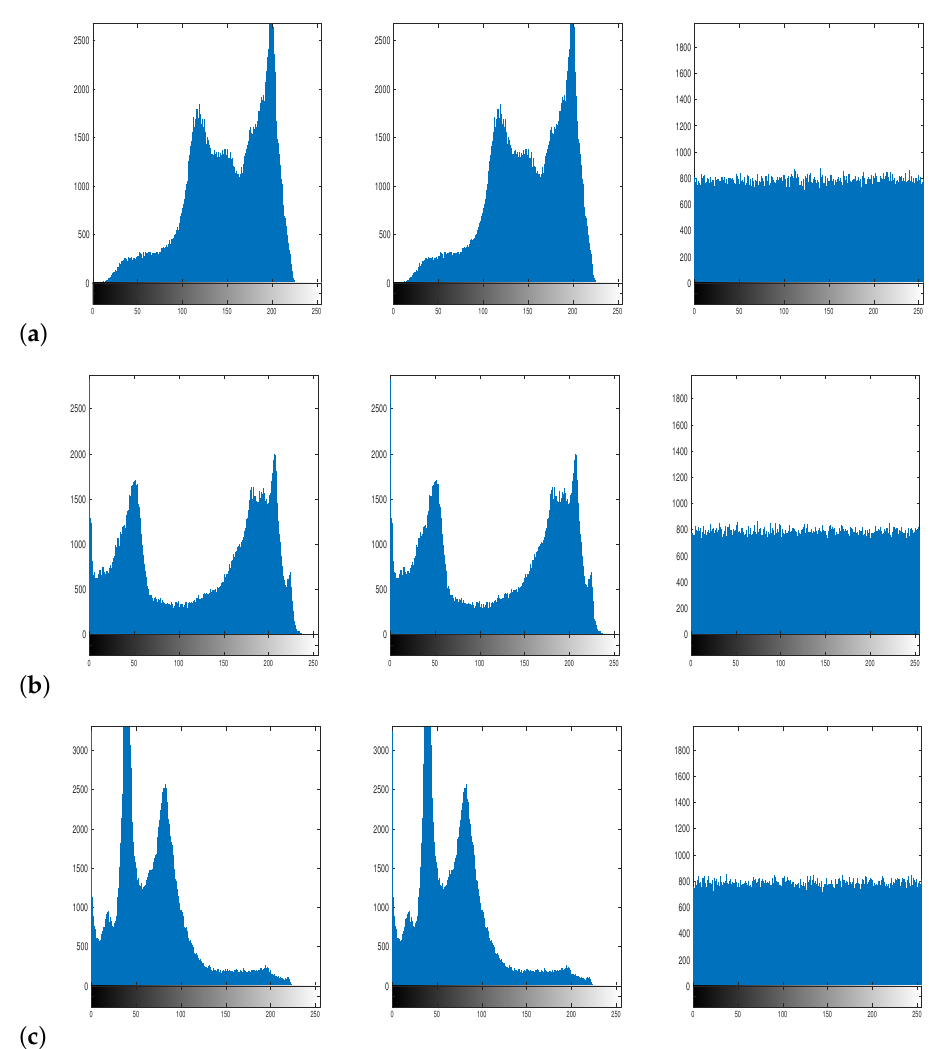
Figure 19. Similar to Figure 16 but for Pepper image. The quantification for the flatness of the histograms can be evaluated through the variance of the histogram, which is defined by [65]